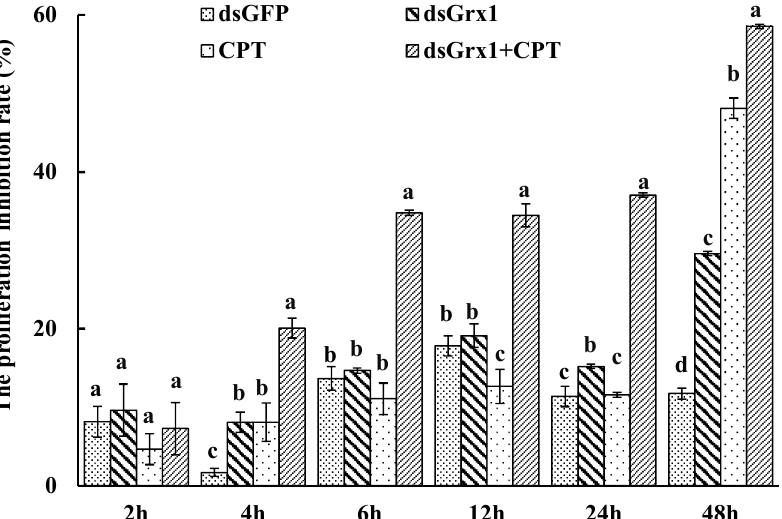
Figure 3. Inhibitory effects of dsRNA and CPT to S. exigua cell line IOZCAS-Spex-II. Inhibition (%) = (OD490 of the 0.1% DMSO-treated cells − OD490 of CPT or/and dsRNA-treated cells)/OD of 0.1% DMSO-treated cells × 100%. Values are shown as mean ± SEM. Data followed by the same lowercase letters among different treatment at the same time indicate no significant difference at 0.05